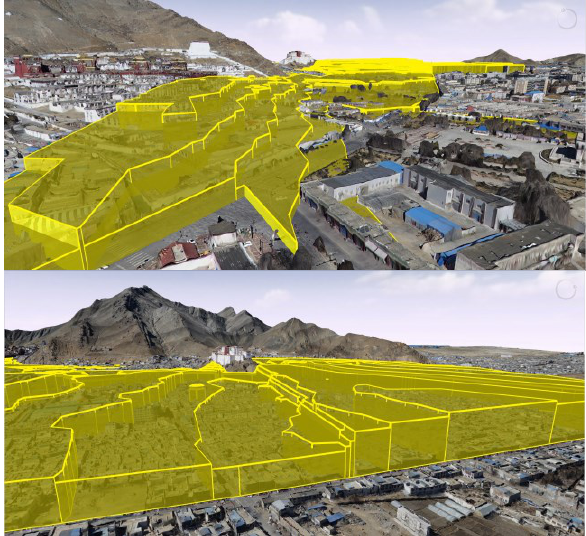
Figure 4. Historic area is generally of low height, while landmarks are located on high grounds, it is not practical to rely solely on visual corridor analysis to set height limits.